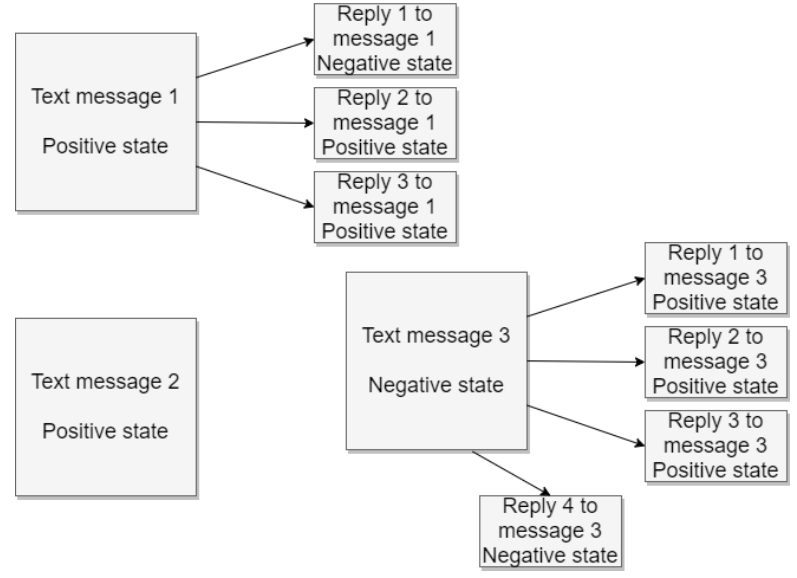
Figure 3. Example of messages posted and replies with different